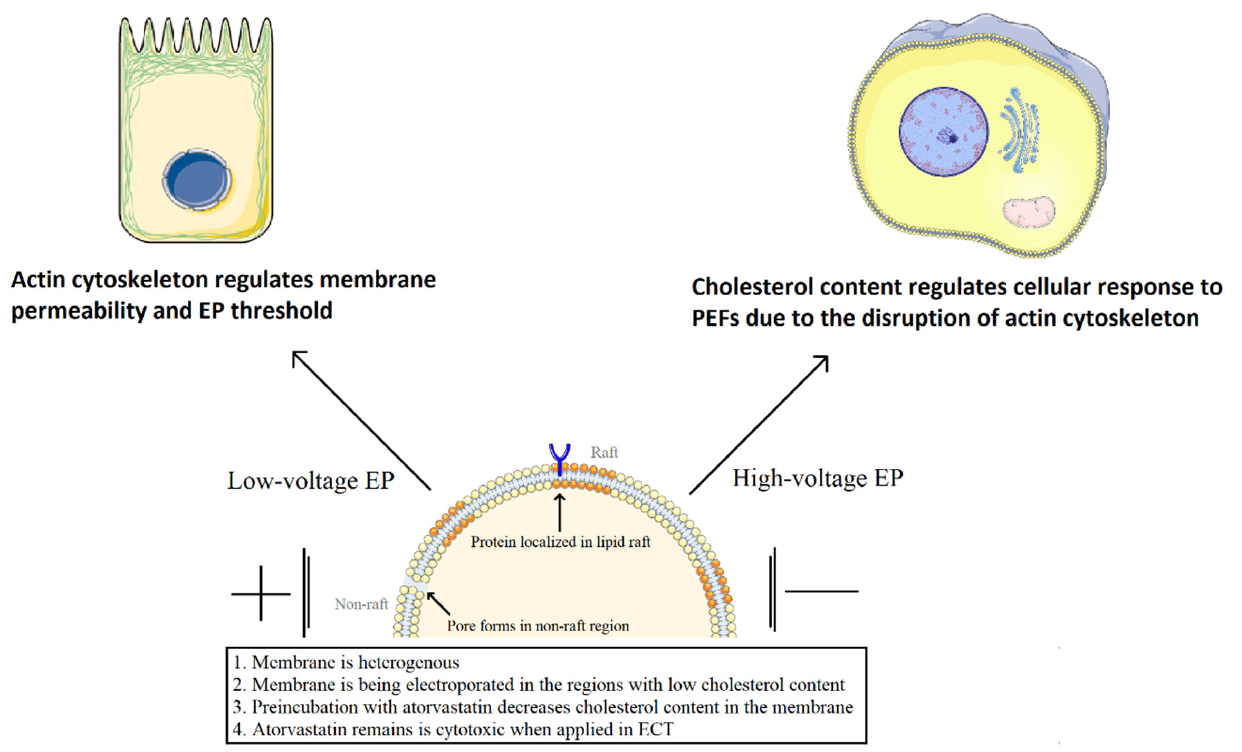
Figure 9. Mechanism of atorvastatin-aided EP.